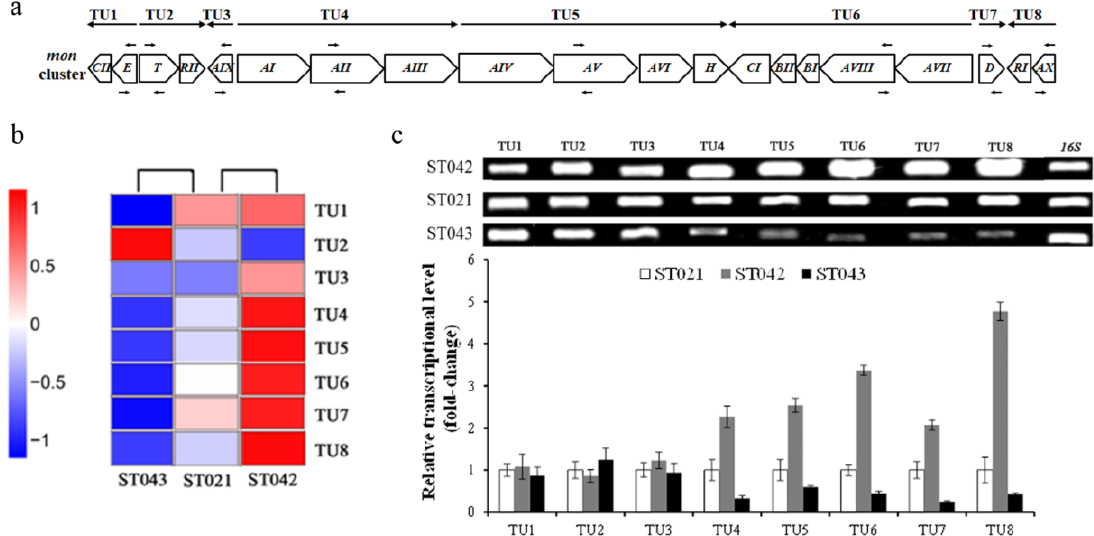
Figure 5. RNA-Seq analysis and RT-PCR verification for transcription of mon cluster. ( a ) Transcription units (TUs) in monensin biosynthesis. ( b ) Heat map of clustering analysis of eight mon TUs by RNA-seq. Expression ratios are shown as log2 values. Red color represents increased expression, while blue color represents decreased expression. ( c ) Relative transcriptional levels of TUs in strains ST042 (grey column) and ST043 (black column) compared to strain ST021 (white column), which were set to 1.0 (arbitrary units) by RT-PCR. Error bars indicate standard deviations from three independent experiments.